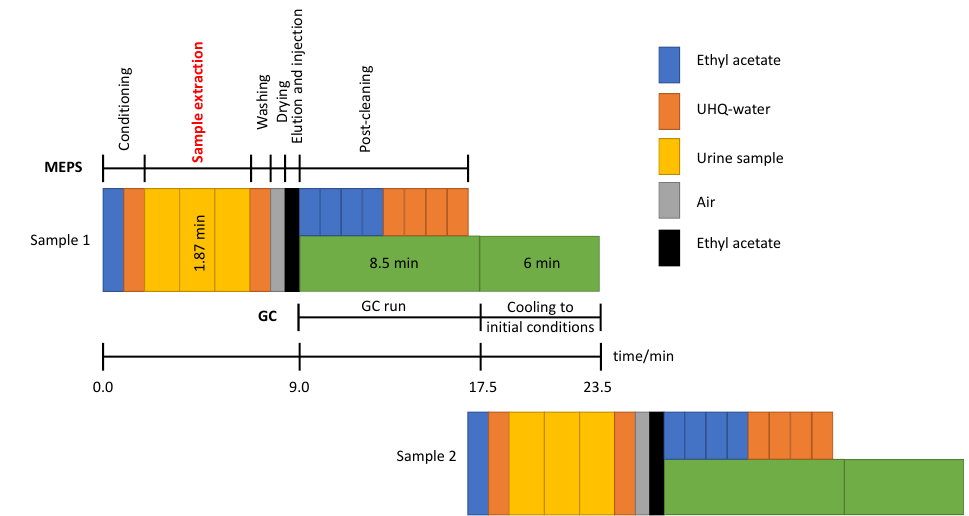
Figure 1. Scheme of the MEPS steps for two consecutive samples.